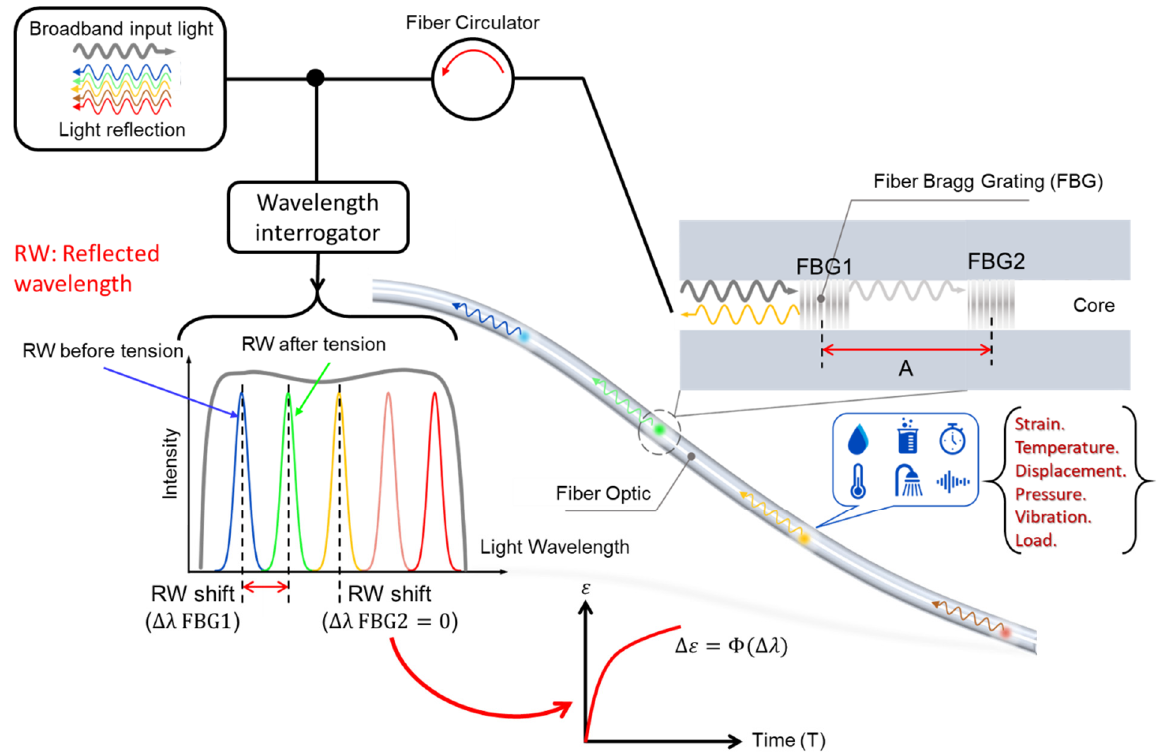
Figure 10. Schematic of the working principle of Fiber Bragg grating (FBG) sensors.